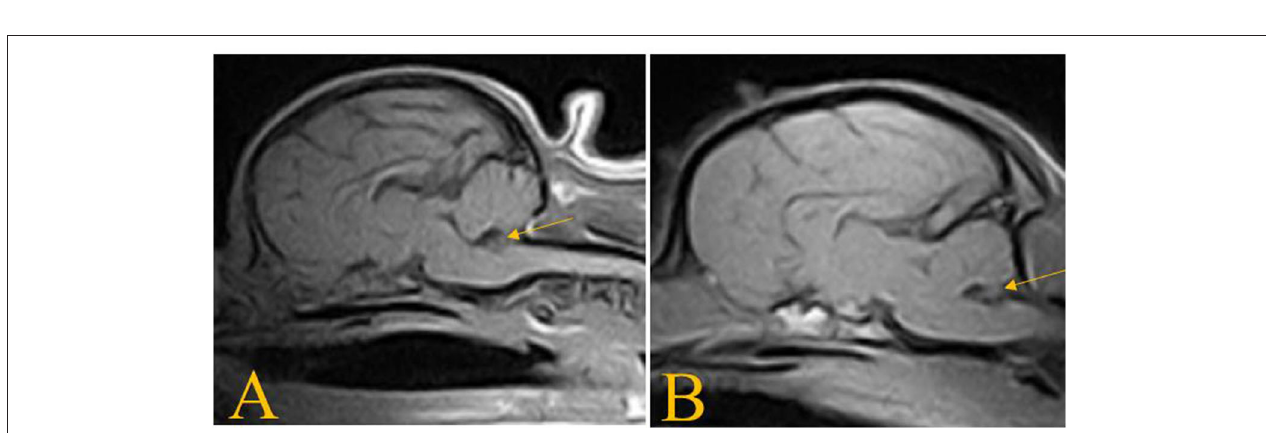
FIGURE 3 | T2W parasagittal and transverse images of the dog in case 1 at the level of nodulus vermis 12 months apart showing non-progressive loss of cerebellar hemisphere tissue in the area of flocculus (arrows).